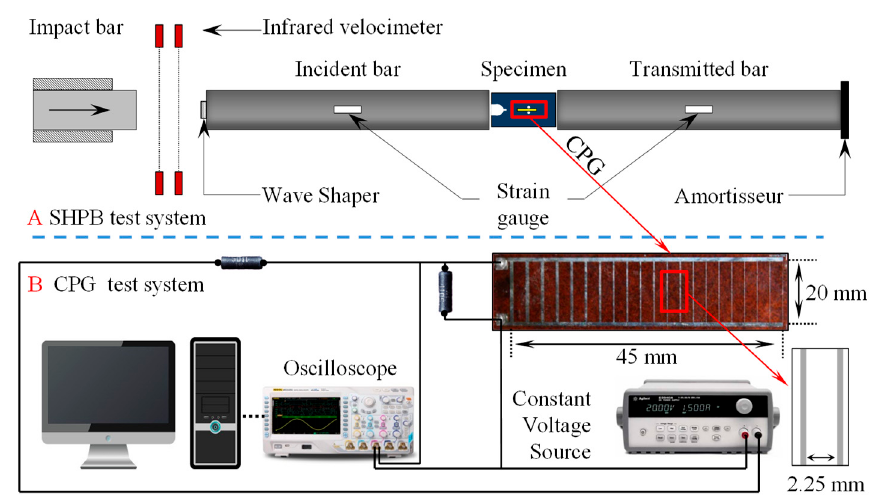
Figure 2. Schematic of the Split Hopkins Pressure Bar (SHPB) test system and crack propagation gauge (CPG) test system.